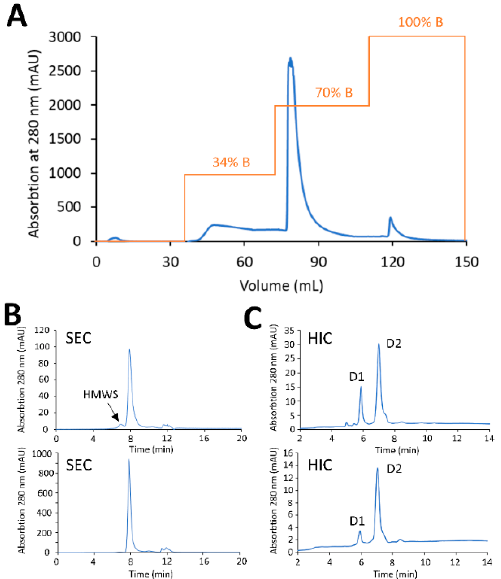
Figure 6. HIC purification of mAb-PBD ADC with the Sartobind ® Phenyl membrane. ( A ) Preparative purification with Sartobind ® Phenyl 3 mL, 8 mm bed height. The loaded sample was stepwise eluted with 34%, 70%, and 100% B. The desired DAR 2 specie was eluted with 70% B. ( B ) SEC profile showing the percentage of aggregate dropped from 5% to less than 1% after Sartobind ® Phenyl purification. ( C ) HIC profile showing the crude reaction mixture contains ADC variants with a range of DAR. The DAR of the purified ADC increased from 1.68 to 1.94.